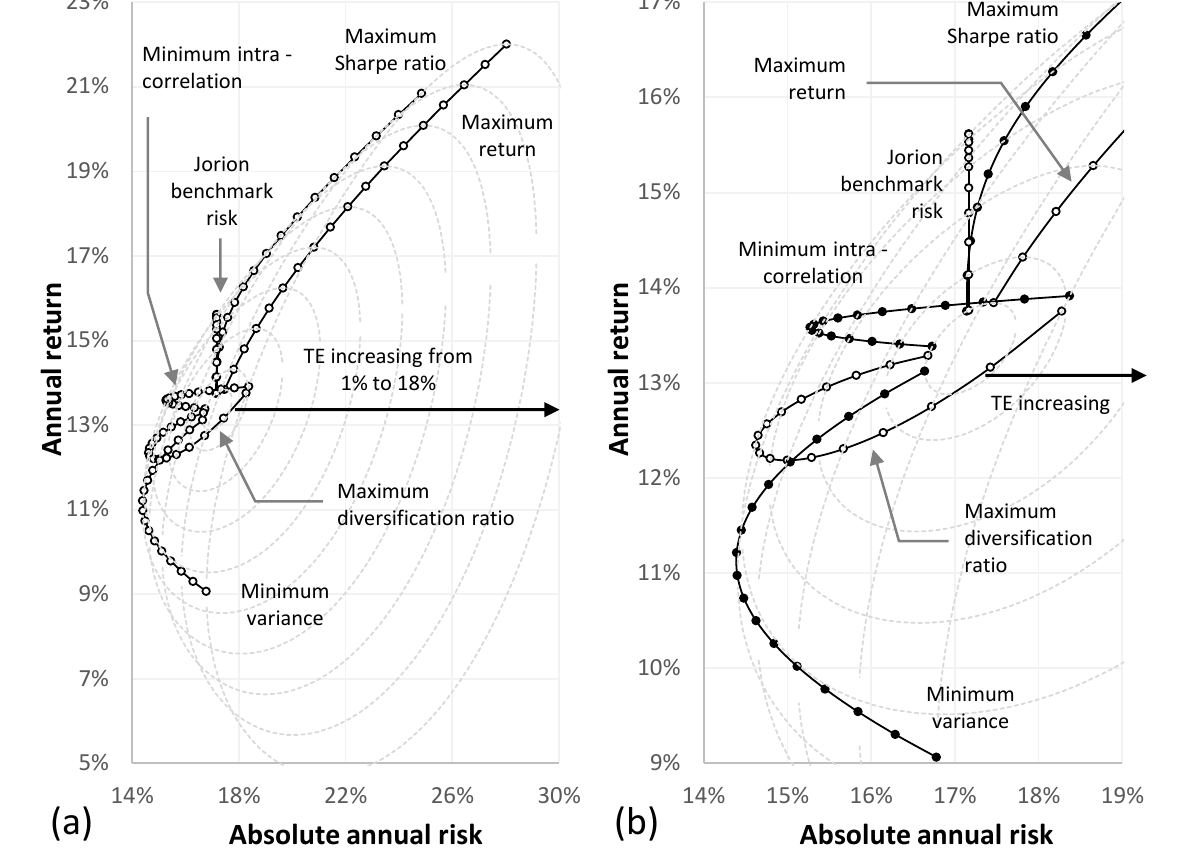
Figure 5. (a) Loci of the six portfolio strategies with respect to changes in their risk/return relationships for increasing TEs and (b) an enlarged section of Figure